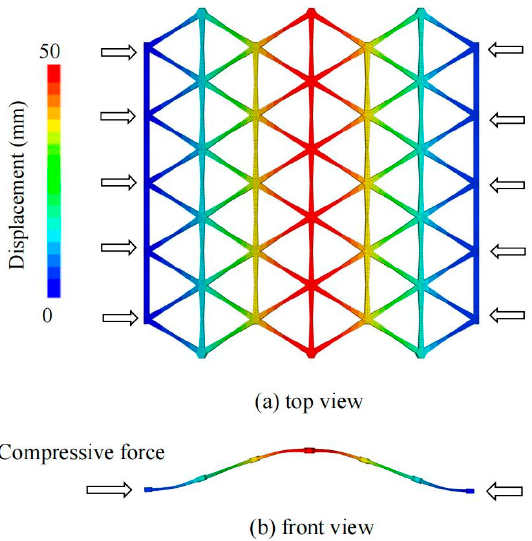
Figure 4. The buckling of the FLAC triaxial geogrid model under compression: ( a ) top view and ( b ) front view.